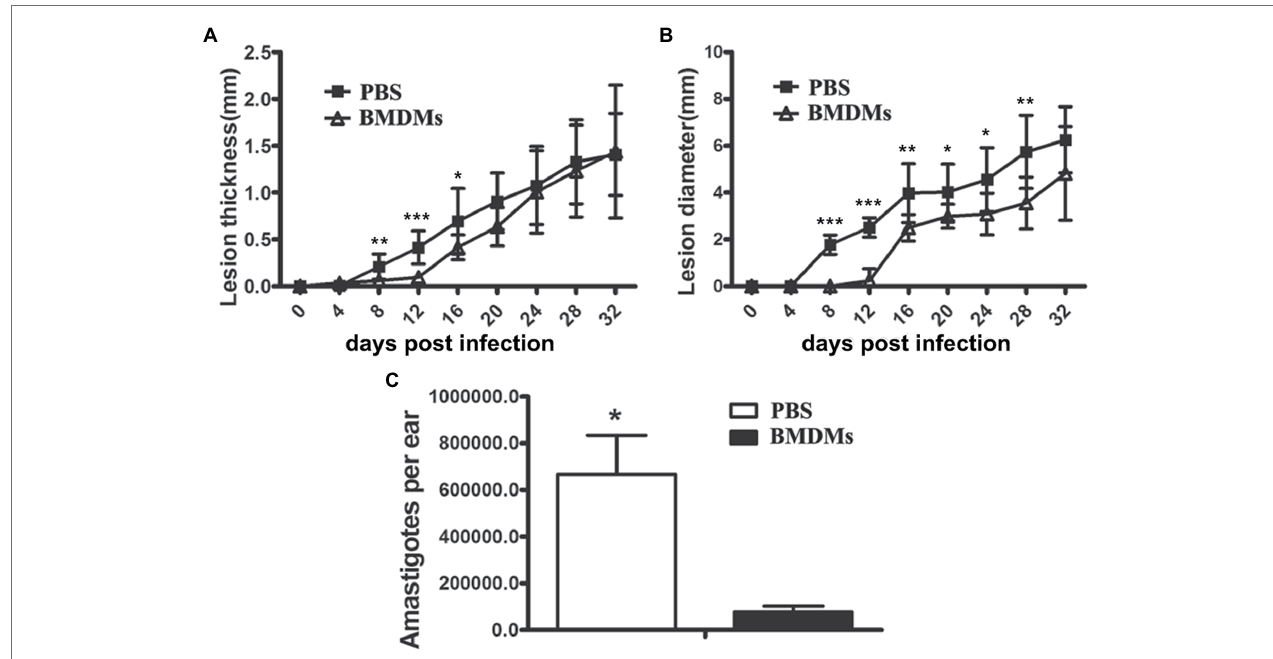
FIGURE 5 | Adoptive transfer of wild-type macrophages to Nos2 − / − rats delayed lesion formation and reduced parasite load. Bone marrow cells were isolated from wild-type rats, cultured and differentiated to macrophages (BMDMs) in 30% L929 cell conditioned medium. Nos2 − / − rats ( N = 5) received 3, 5, 5, 8 × 10 6 wild-type rat BMDMs at 0, 8, 16, and 24 days postinfection, respectively. Lesion thickness (A) and diameter (B) were measured every 4 days. (C) Parasite burden (mean ± SD) on 32 DPI was determined by Limiting dilution assay. * indicates a significant difference (0.01 ﹤ P ﹤ 0.05); **(0.001 ﹤ P ﹤ 0.01); ***( P ﹤